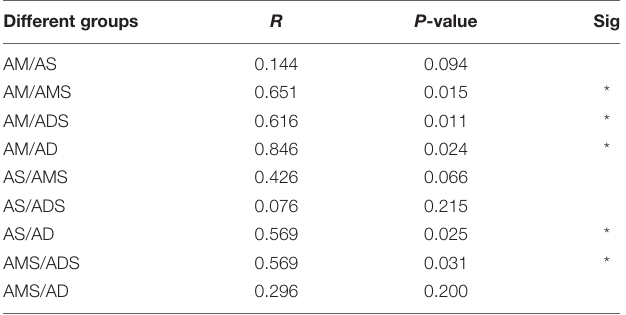
TABLE 2 | Analysis of similarities (ANOSIM) of soil bacteria in alpine grasslands on the Tibetan Plateau. Different